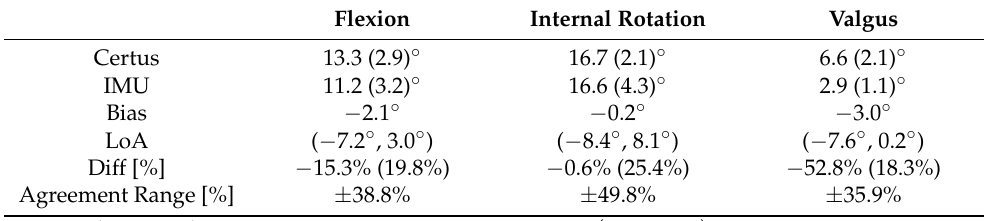
Table 2. Mean (SD) peak angle changes measured via Certus and IMUs, along with the corresponding Bland–Altman bias and limit of agreement results calculated according to the formula in the table footnote at bottom